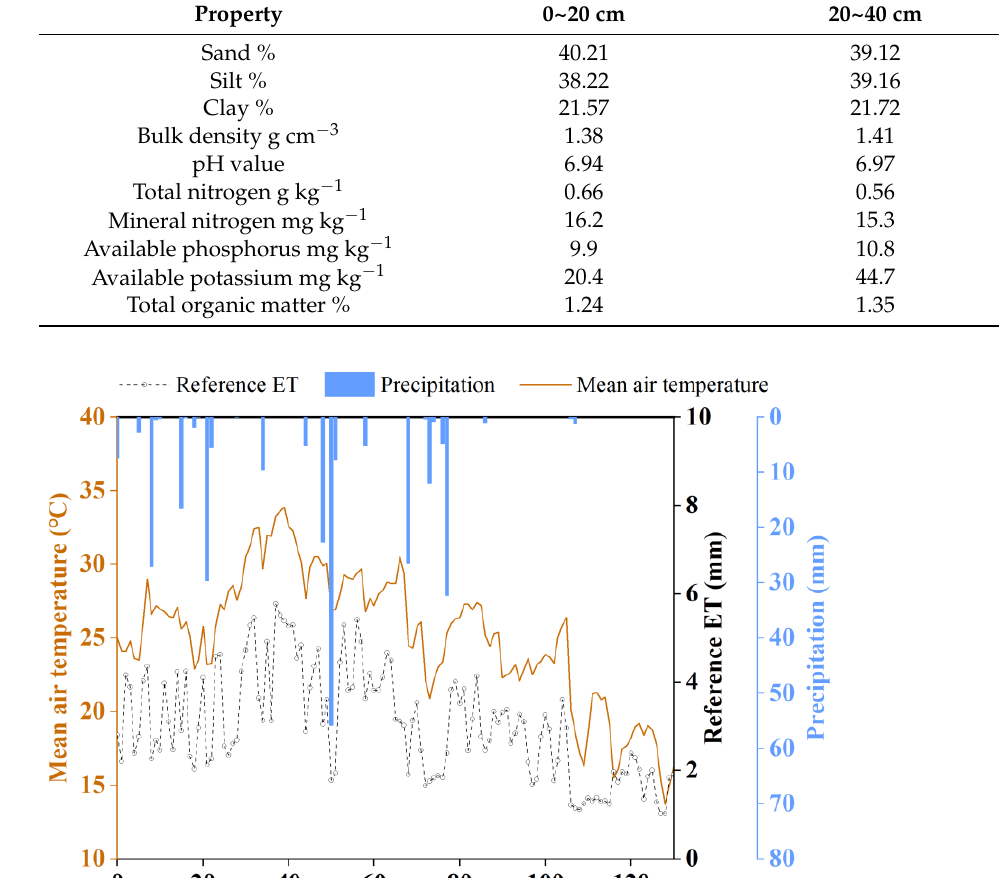
Table 1. Initial properties of the experimental soil at 0~40 cm depth.